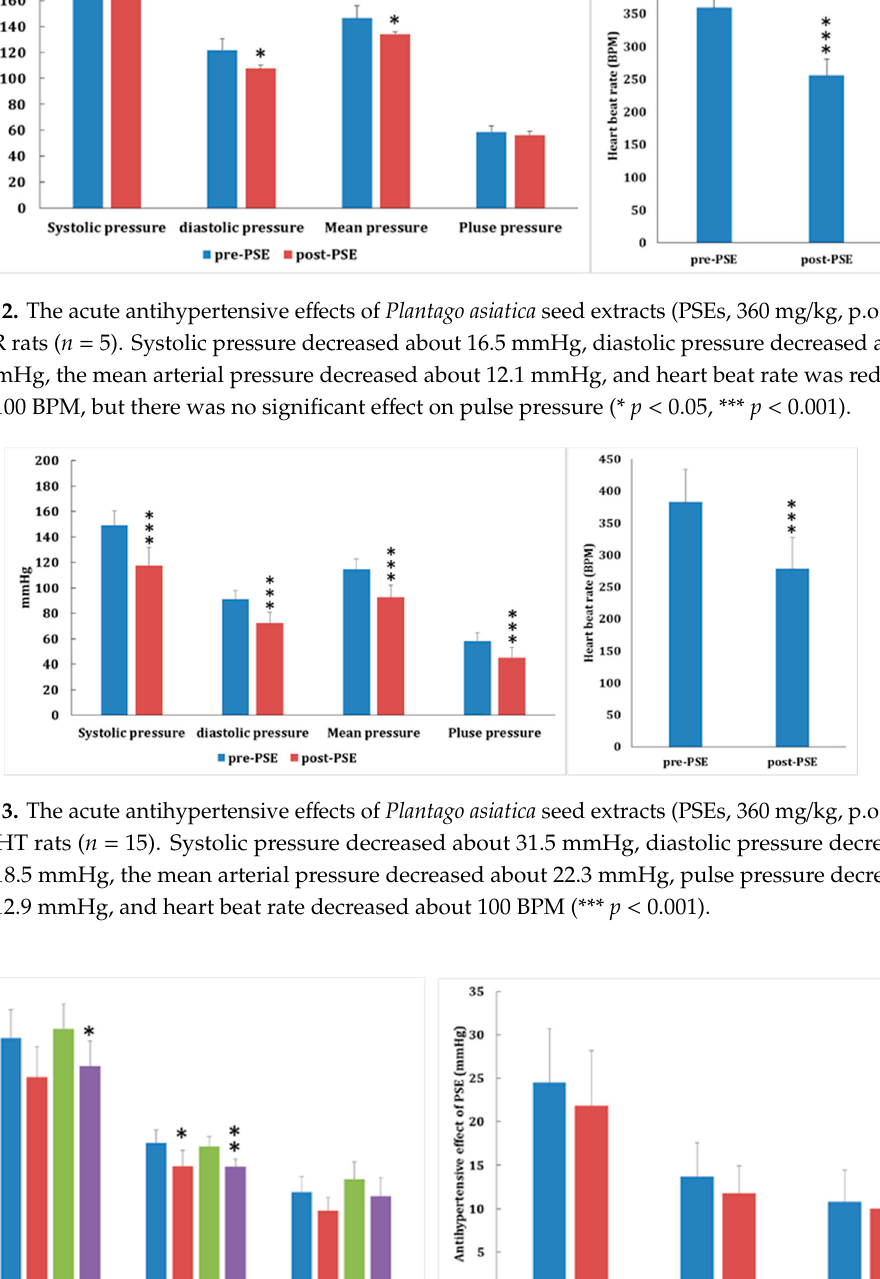
Figure 2. The acute antihypertensive effects of Plantago asiatica seed extracts (PSEs, 360 mg/kg, p.o., 1 h) on SHR rats ( n = 5). Systolic pressure decreased about 16.5 mmHg, diastolic pressure decreased about 14.3 mmHg, the mean arterial pressure decreased about 12.1 mmHg, and heart beat rate was reduced about 100 BPM, but there was no significant effect on pulse pressure (* p < 0.05, *** p < 0.001).